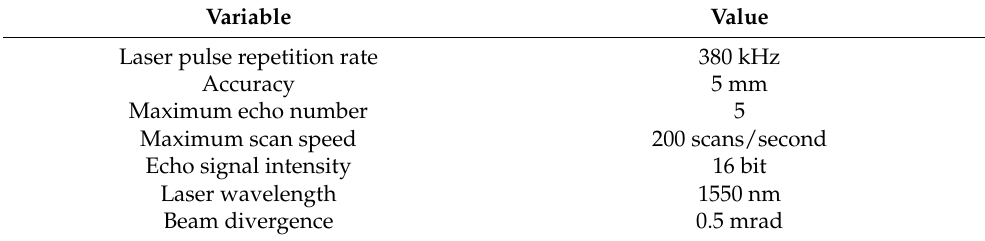
Table 2. Details of the operational parameters for the UAVLS data